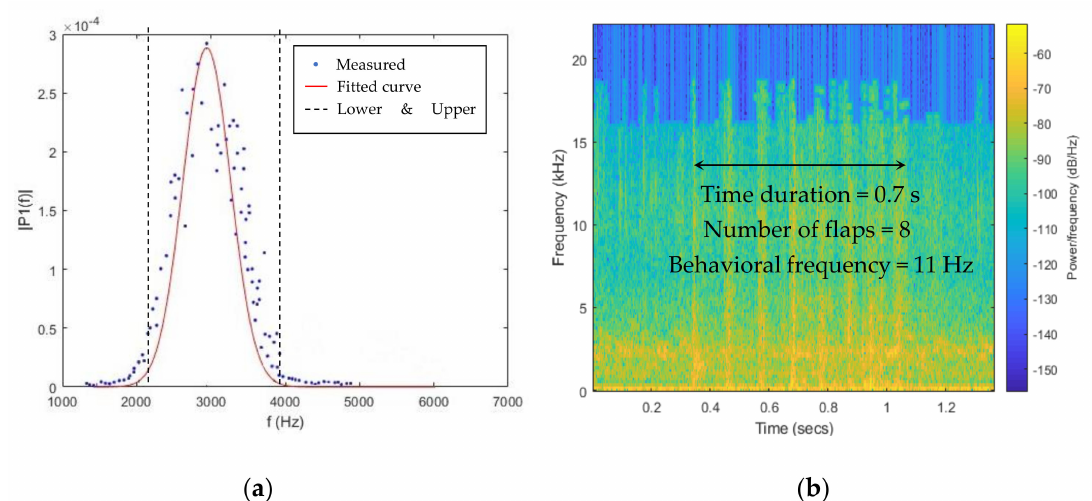
Figure 5. Example of Gaussian regression ( a ) and calculation of behavioral frequency ( b ). The sound sources of two sounds are bird vocalization ( a ) and wing flapping ( b ),